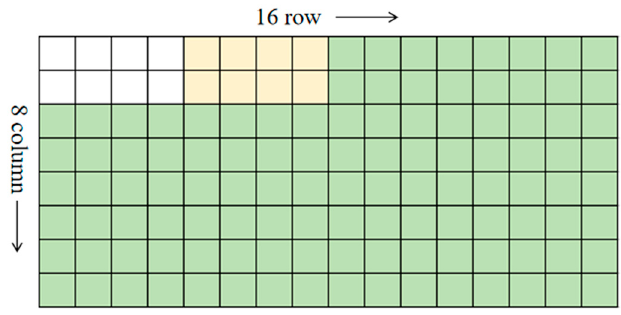
Figure 2. The diagram of partition with empty cells.